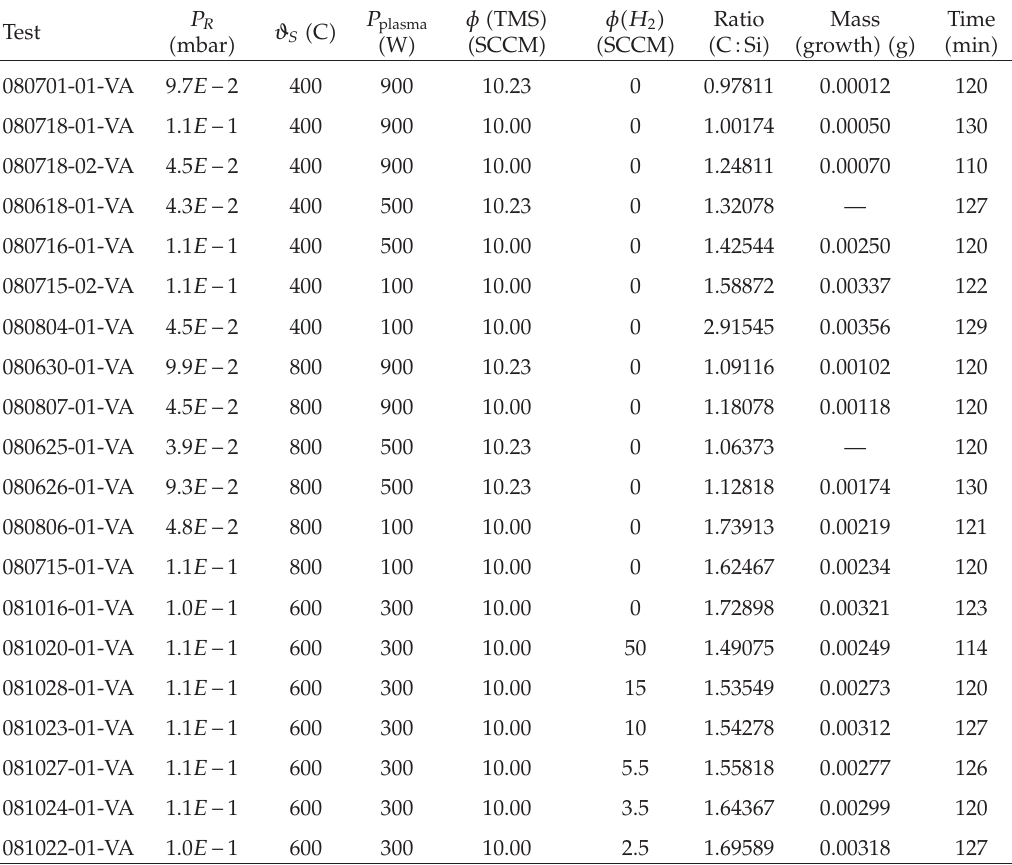
Table 1: The physical experiments with the real-life